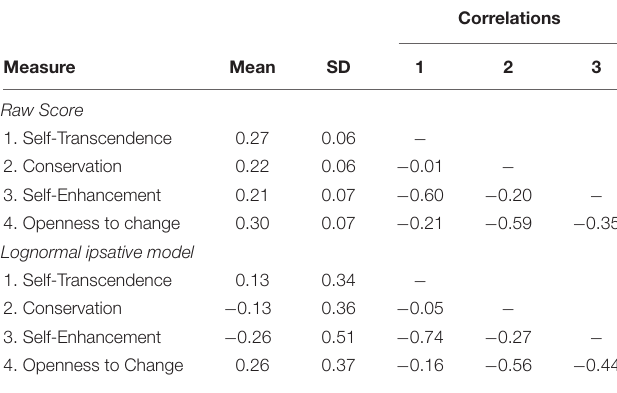
TABLE 3 | Summary of the means, standard deviations, and correlations of the four measures in the raw score and in the lognormal ipsative model.